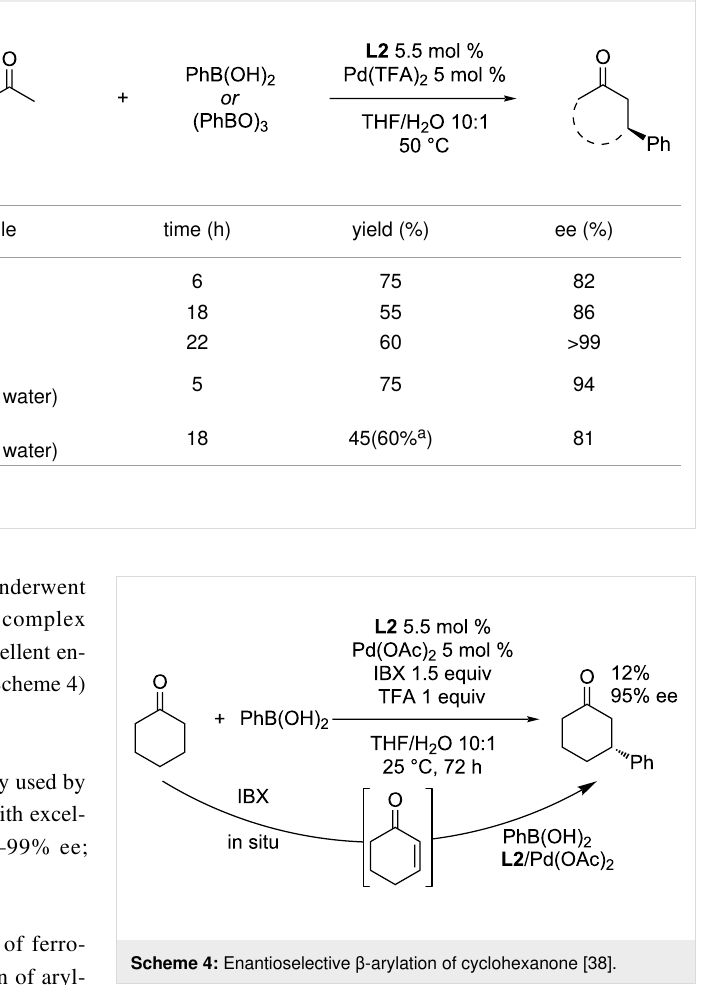
Table 8: Addition of boron-derived C -nucleophiles to cyclic enones, catalysed by L2 /Pd(TFA) 2